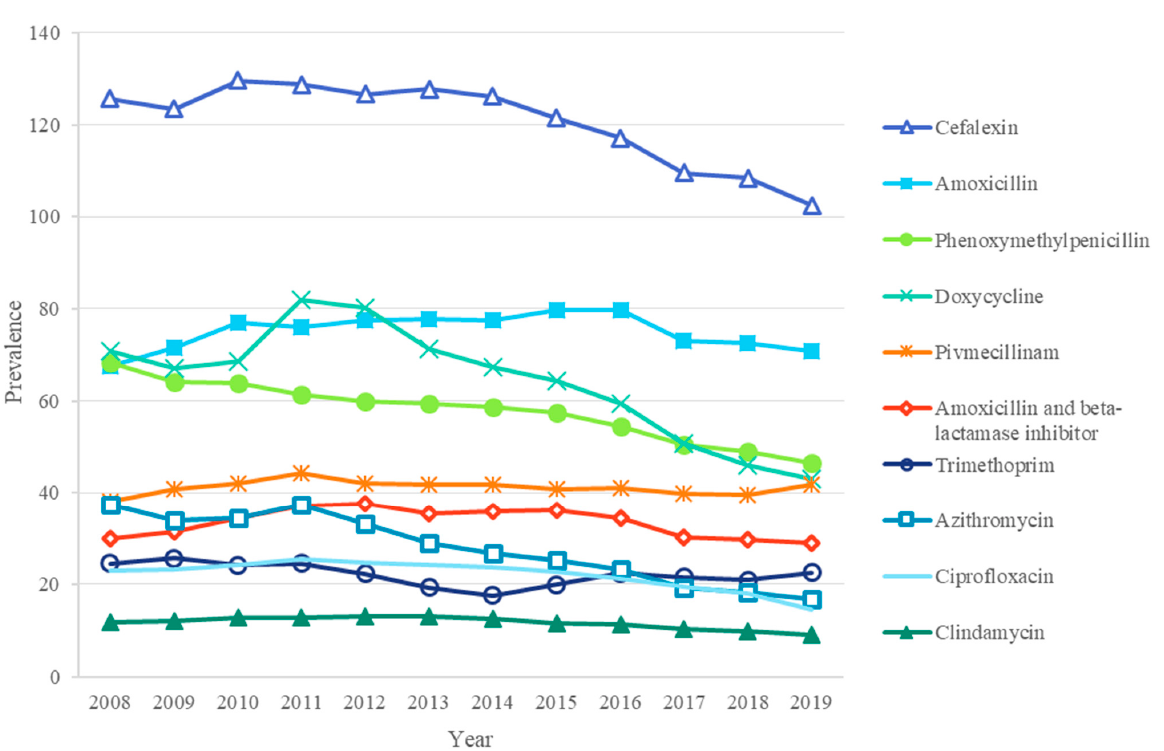
Figure 2. Prescription rate (prescriptions per 1000 adults per year) of the ten most frequently used antibiotics in Finland from 2008–2019.